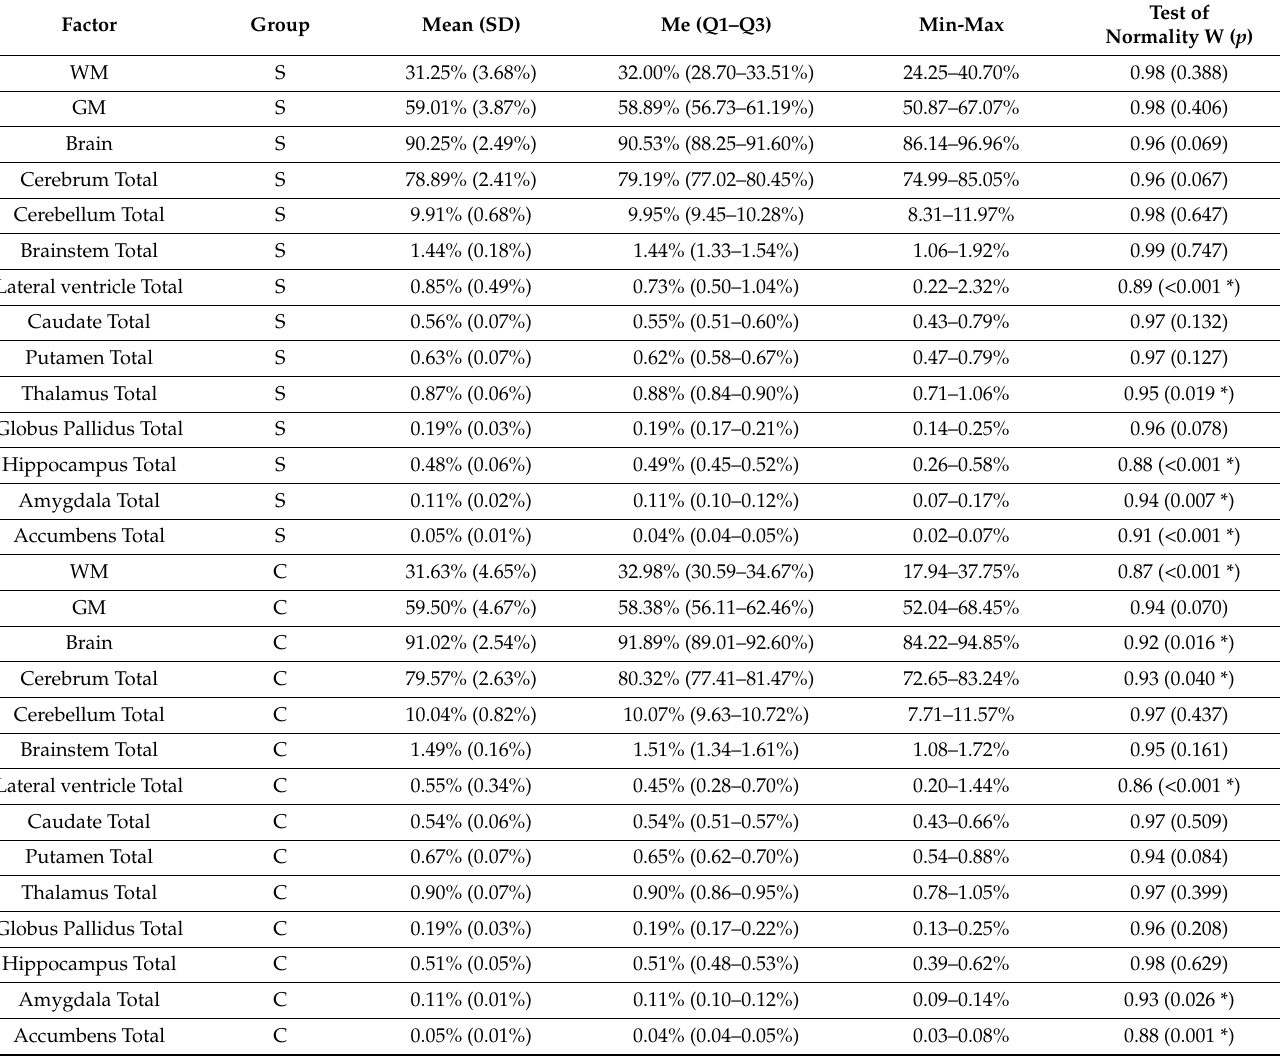
Table 2. Normality test for the quantitative variables. Descriptive statistics (mean, median with lower and upper quartiles, min-max) with the statistical analysis (Shapiro–Wilk W test); statistically significant difference marked by “*”